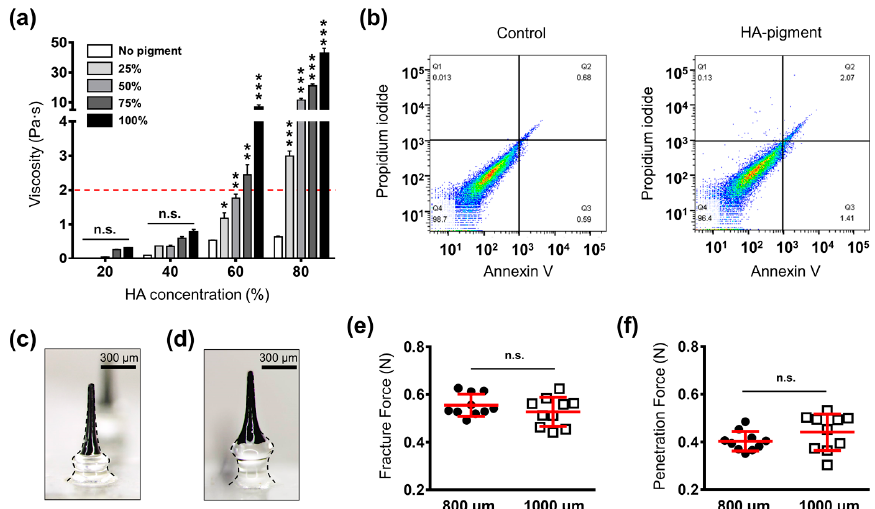
Figure 2. Optimization of micro-pigment-encapsulated biodegradable microneedle (PBM) fabrication parameters. ( a ) Evaluation of hyaluronic acid (HA)-pigment mixture viscosity. Increasing the